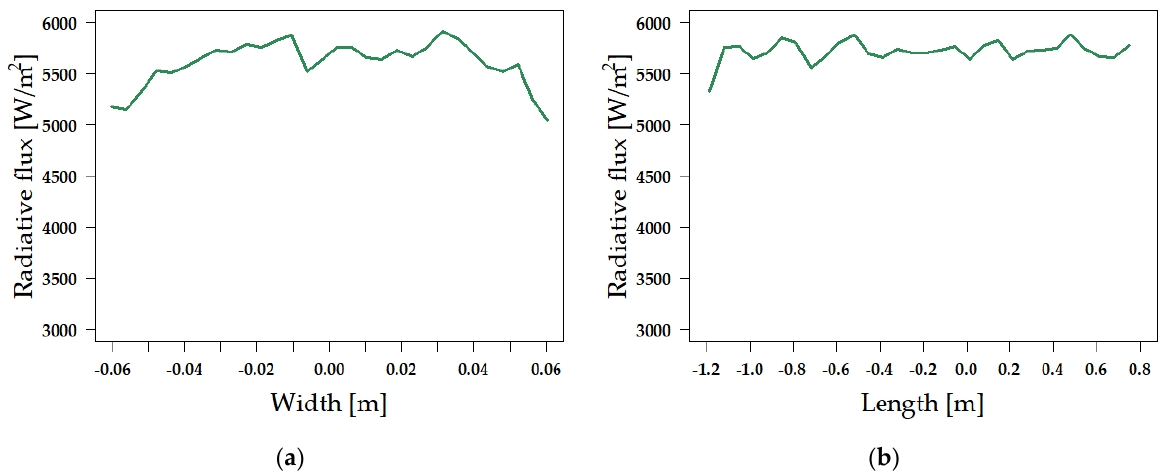
Figure 10. Radiative flux distribution for the concentration ratio of 13.0 and displacement of 0.14 m at: ( a ) cross-section; ( b ) longitudinal section of the receiver.